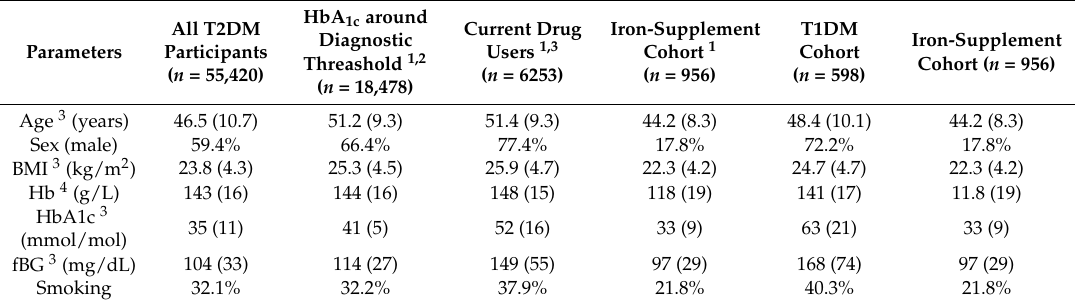
Table 1. Characteristics of the study